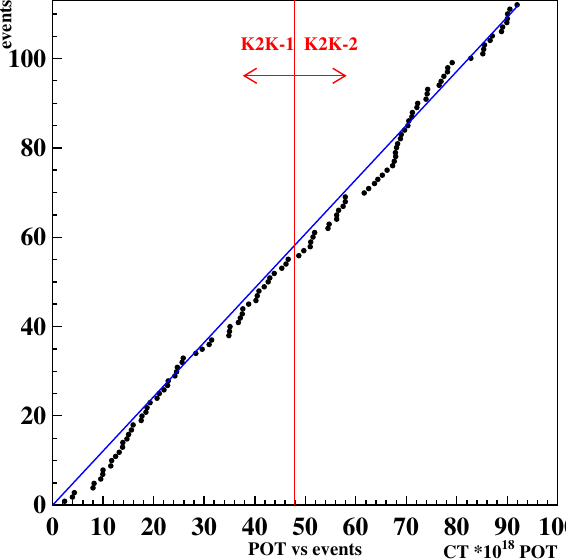
Fig. 29 Event rate as a function of POT. If the event rate was propor- tionaltoPOT, theKS-testprobabilitytoobservethiseventratewas79%